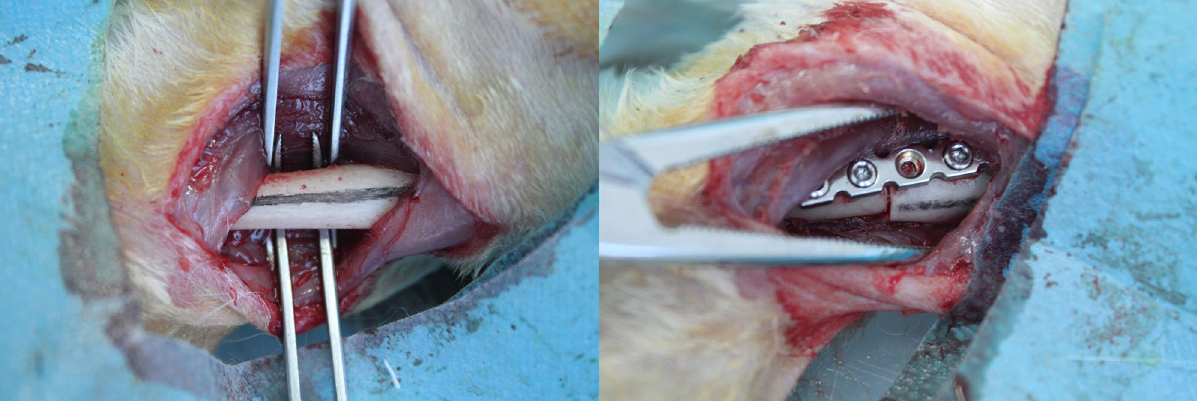
Figure 1. Intraoperative exposure of the humerus shaft and internal fixation after